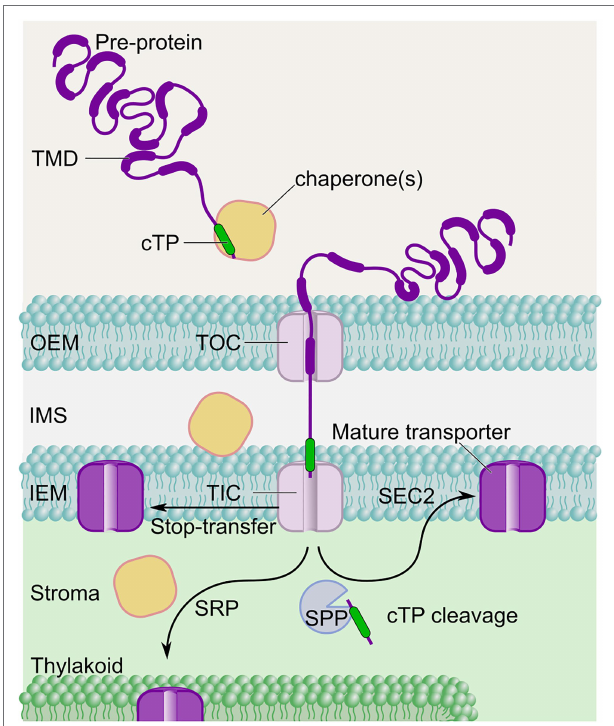
FIGURE 3 | Possible pathways for membrane HCO 3 − transporter insertion in C 3 chloroplasts. For successful targeting to the correct membrane in C 3 chloroplasts, candidate inorganic carbon uptake system proteins need to utilize an appropriate chloroplast targeting peptide (cTP) at the N-terminus of the nuclear-encoded pre-protein. Chaperones co-ordinate transit of membrane pre-proteins to the TIC-TOC translocons enabling initial import into the chloroplast. Here, proteins can undergo a number of localization processes, dependent on sequence motifs and interactions. Proteins destined for the IEM are handled by the stop-transfer or post-import (SEC2) pathways, whereas the signal recognition particle (SRP) pathway is utilized by proteins destined for the thylakoid (Lee et al., 2017). Ultimate localization can be partly driven by transmembrane domain (TMD) sequences (Rolland et al., 2017; Singhal and Fernandez, 2017). The stromal processing peptidase (SPP) must recognize and cleave the cTP in such a way that no functionally disruptive scar is left behind on mature transporters when they reach their proper destination. Very little is known about targeting foreign proteins to the